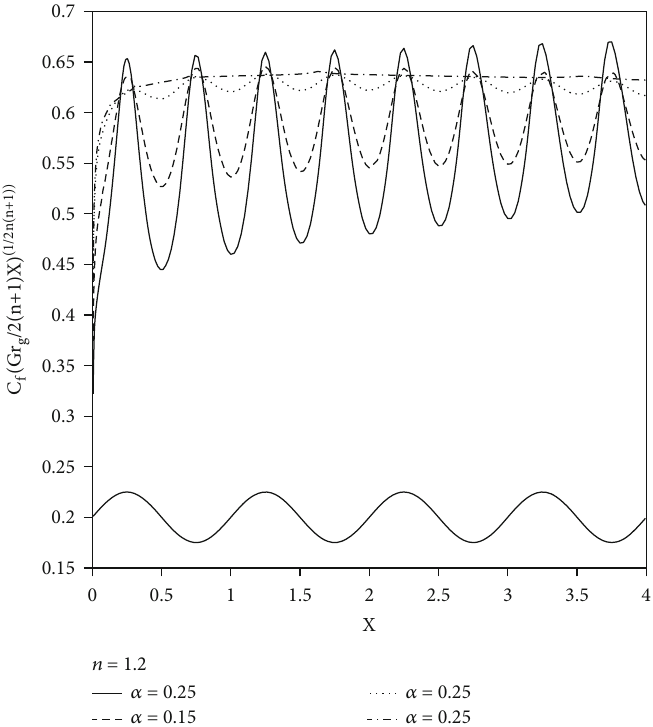
Figure 12: The axial distribution of the skin friction coe ffi cient for Pr